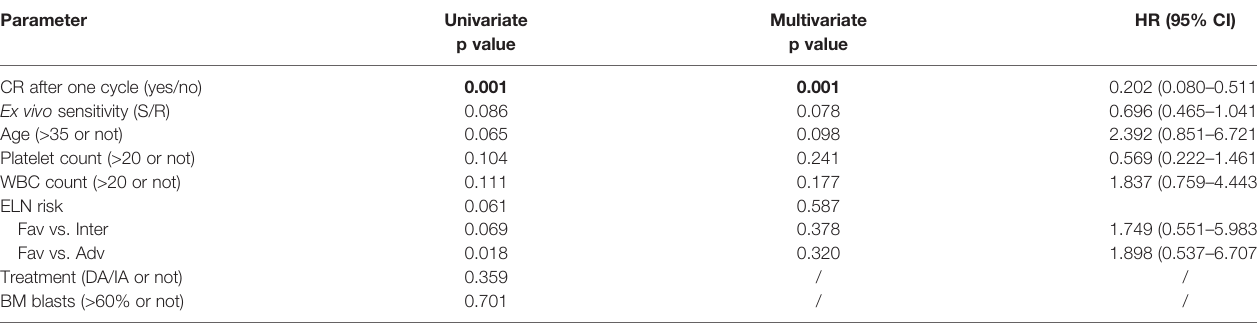
TABLE 2 | Univariate and multivariate analysis for overall survival. Parameter